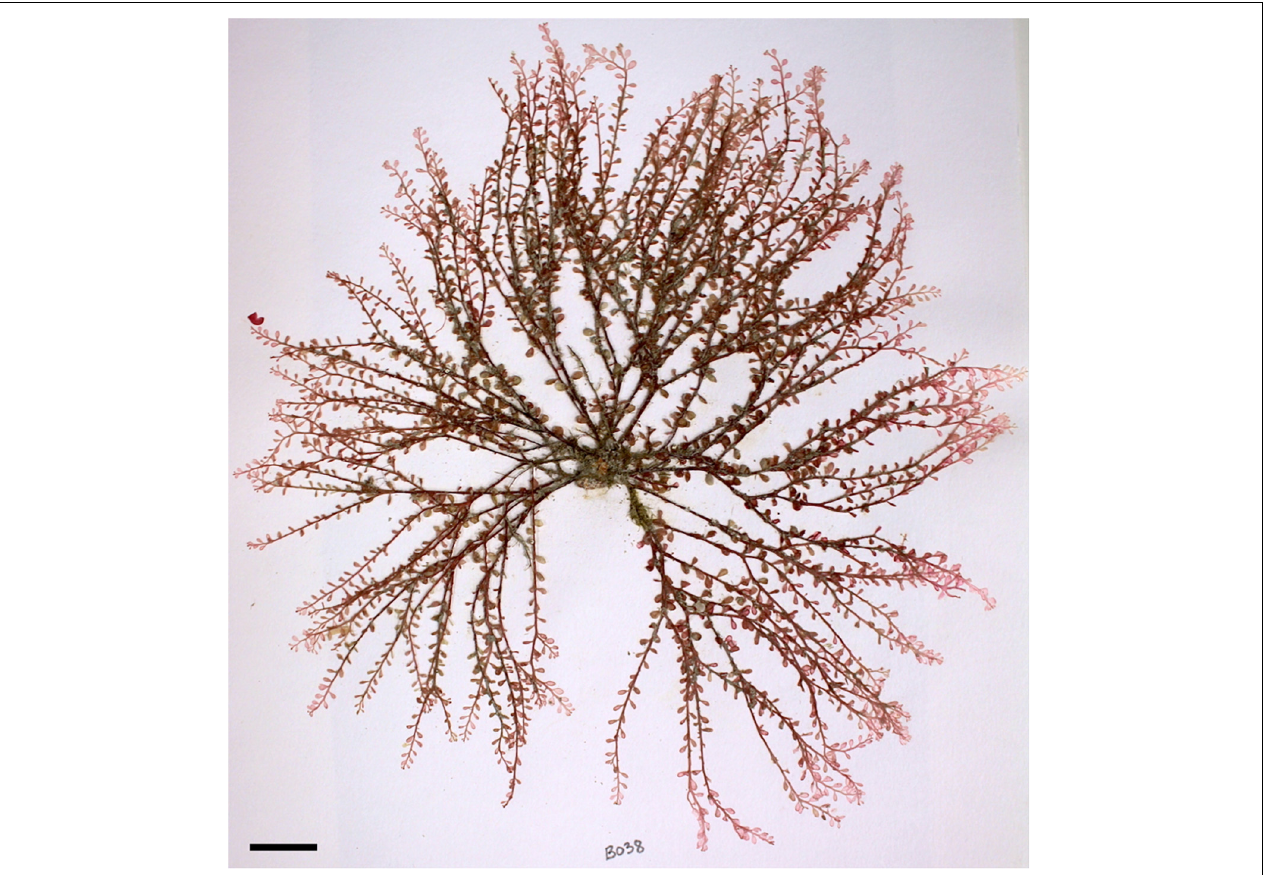
FIGURE 1 | Herbarium specimen of Botryocladia occidentalis (scale bar: 2 cm) collected in the Florida Middle Grounds (28 ◦ 5.20 (cid:48) N, 83 ◦ 46.16 (cid:48) W) during the research cruise NSFIII (collect date: July 05, 2006) of the University of Louisiana at Lafayette (LAF) Seaweeds Lab. This specimen, referenced NSFIII-7-5-06-8-2 in the LAF Herbarium, is part of the biological material used in this